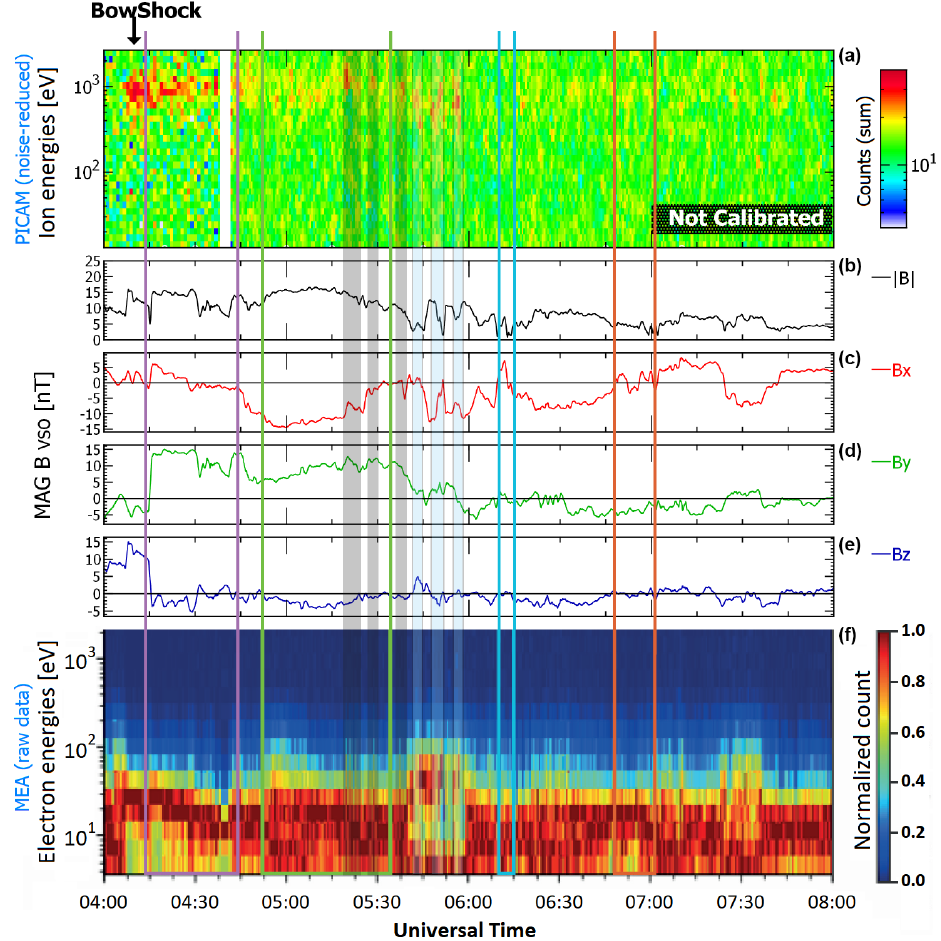
Figure 9. Four hours of the Venus 1 flyby as seen by different instruments. Panel (a) shows the PICAM data, where the ∼ 1keV protons are clearly visible before and behind the bow shock. The data gap near ∼ 04:40UT is caused by a mode change. Panels (b) – (e) show the MAG data, B -field magnitude, and components. Panel (f) shows the linearly normalized MEA omnidirectional electron count time–energy spectrogram. The coloured lines (purple, green, cyan, and red) and the shaded areas (transparent grey, transparent blue) show the different intervals as defined in the